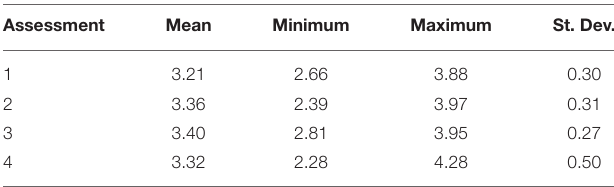
TABLE 5 | Pearson’s correlation coefficient for indicators scored by both qualitative (expert opinion workshop) and quantitative (biodiversity field survey)